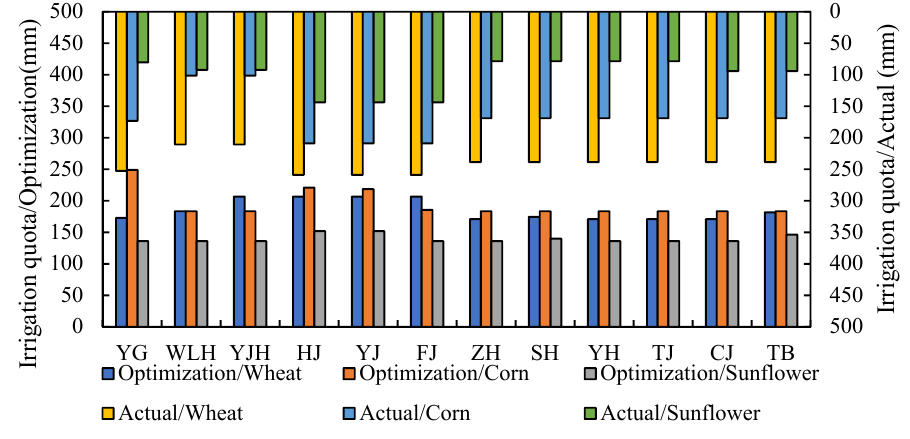
Figure 11. Results of water resources allocation in HID.